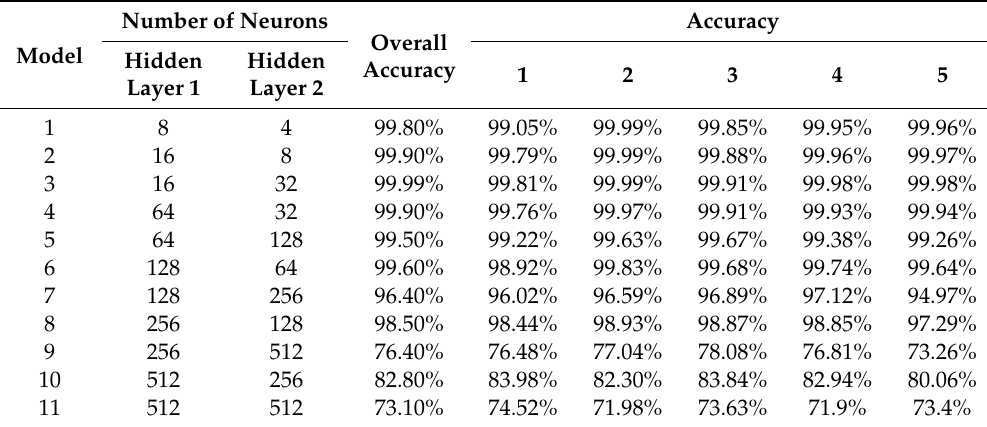
Table 7. Validation result of training using dataset A (19 July 2019